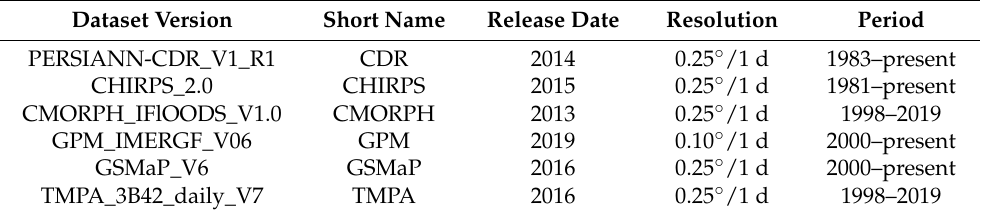
Table 1. Summary of satellite precipitation datasets used in this